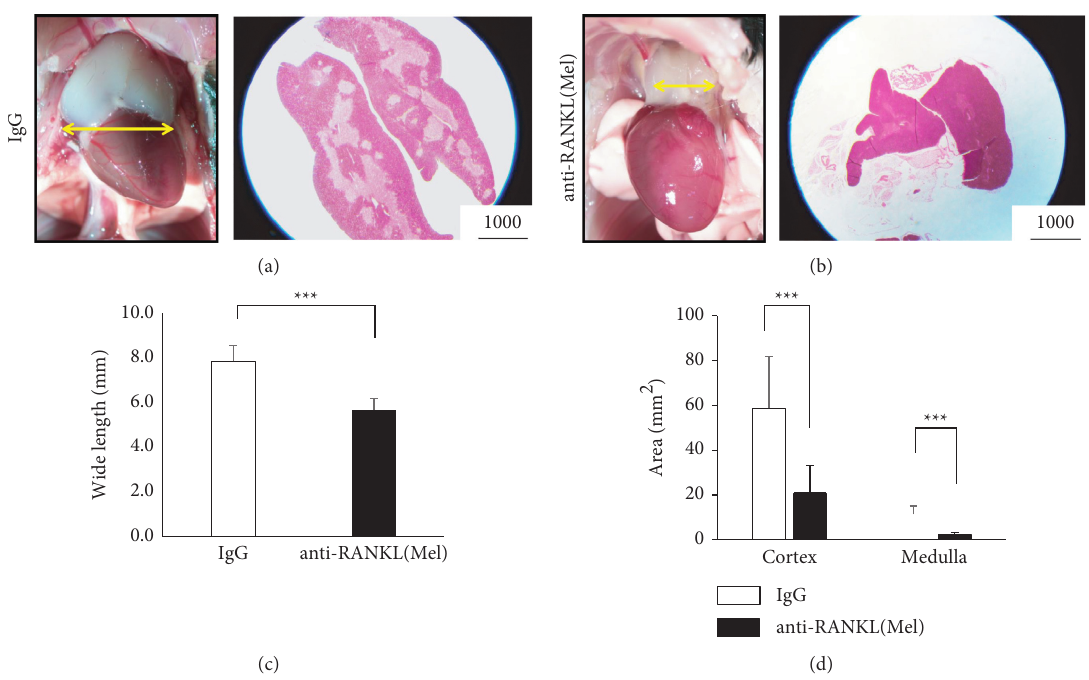
Figure 2: Anti-RANKL/Mel administration causes atrophy of the thymus. (a) The left panel shows the representative gross appearance of the thymus in IgG. Yellow arrows indicate the wide length of the thymus. The right panel shows H&E staining of a low magnification image of the thymus. Bar is 1000 μ m. (b) The left panel shows the representative gross appearance of the thymus in anti-RANKL/Mel. Yellow arrows indicate the wide length of the thymus. The right panel shows H&E staining of a low magnification image in the thymus. Bar is 1000 μ m. (c) Wide length of the thymus in IgG vs. anti-RANKL/Mel. (d) Area of the cortex and medulla of the thymus in IgG vs. anti- RANKL/Mel. Graphs show mean ± SEM. ∗∗∗ p < 0 .